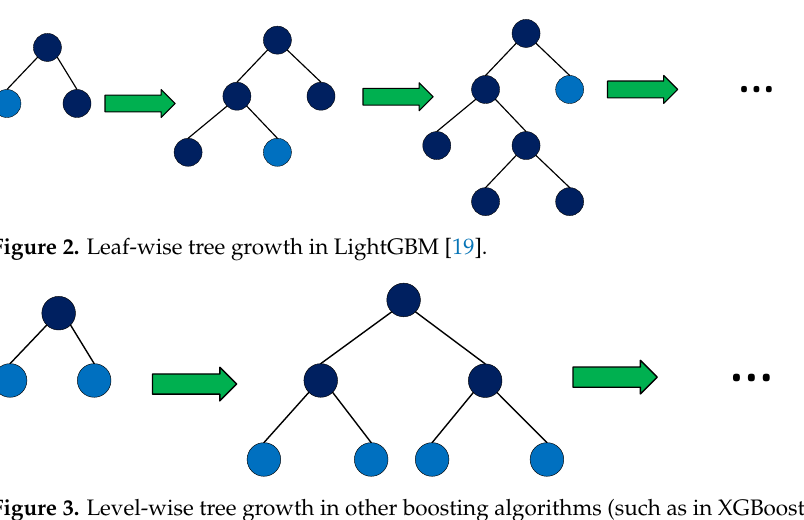
Figure 3. Level-wise tree growth in other boosting algorithms (such as in XGBoost) [19]. For a small size of data, leafwise growing may lead to an increase in complexity and result in overfitting [46]. To overcome this problem, we optimized the LightGBM algorithm for our medium size data ZMHDD (2000+) by precalculating the optimal values of the model’s hyperparameters to control the complexity of the LightGBM model. These are ( i. ) the number of iterations, ( ii. ) the maximum depth of the trees, and ( iii. ) the number of leaves. Hence, we retrieve the optimum number of trees, maximum depth of trees, and number of tree leaves. Details on the optimization process are given in Section